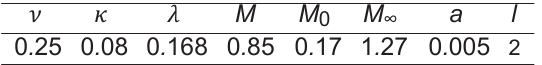
initial void ratio is 0 . 72.